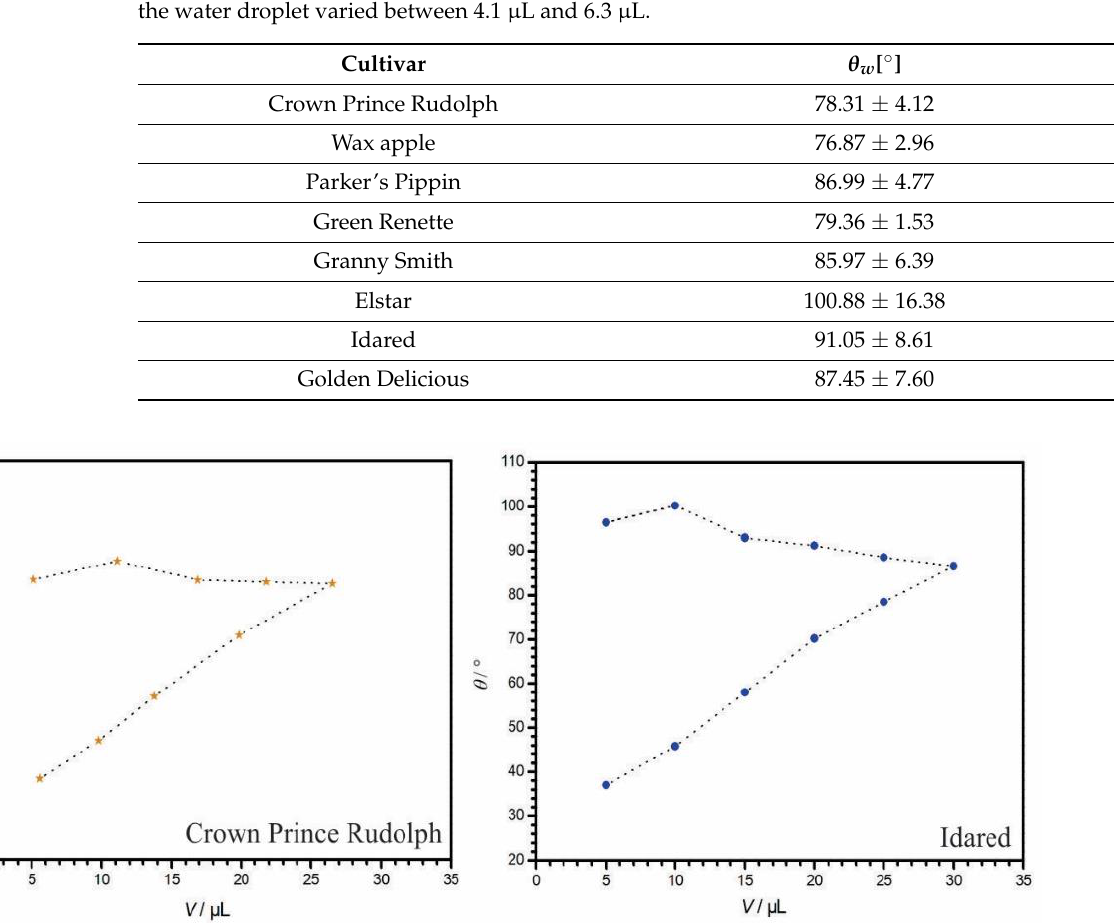
Figure 3. Advancing and receding angles of water droplets on the surface of Crown Prince Rudolph and Idared.